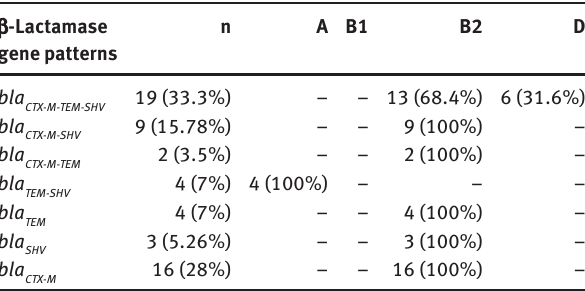
Table 2: Distribution of different β -lactamase gene patterns in four phylogroups (A, B1, B2,